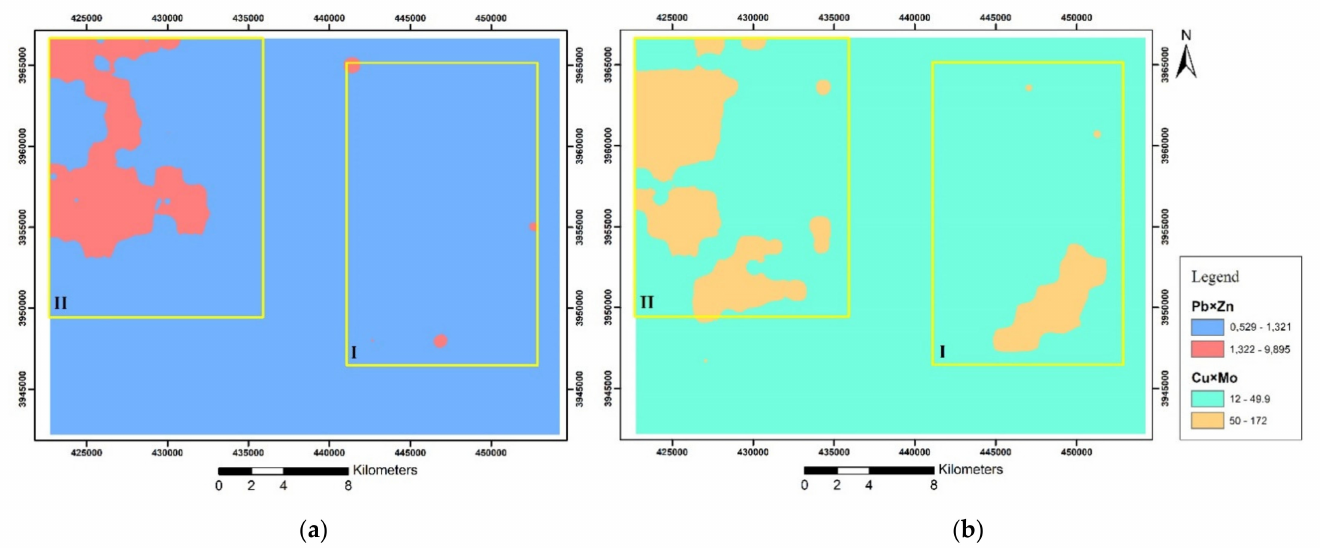
Figure 4. Geochemical maps of ( a ) supra-ore and ( b ) sub-ore elements, zones I and II, in the study area.